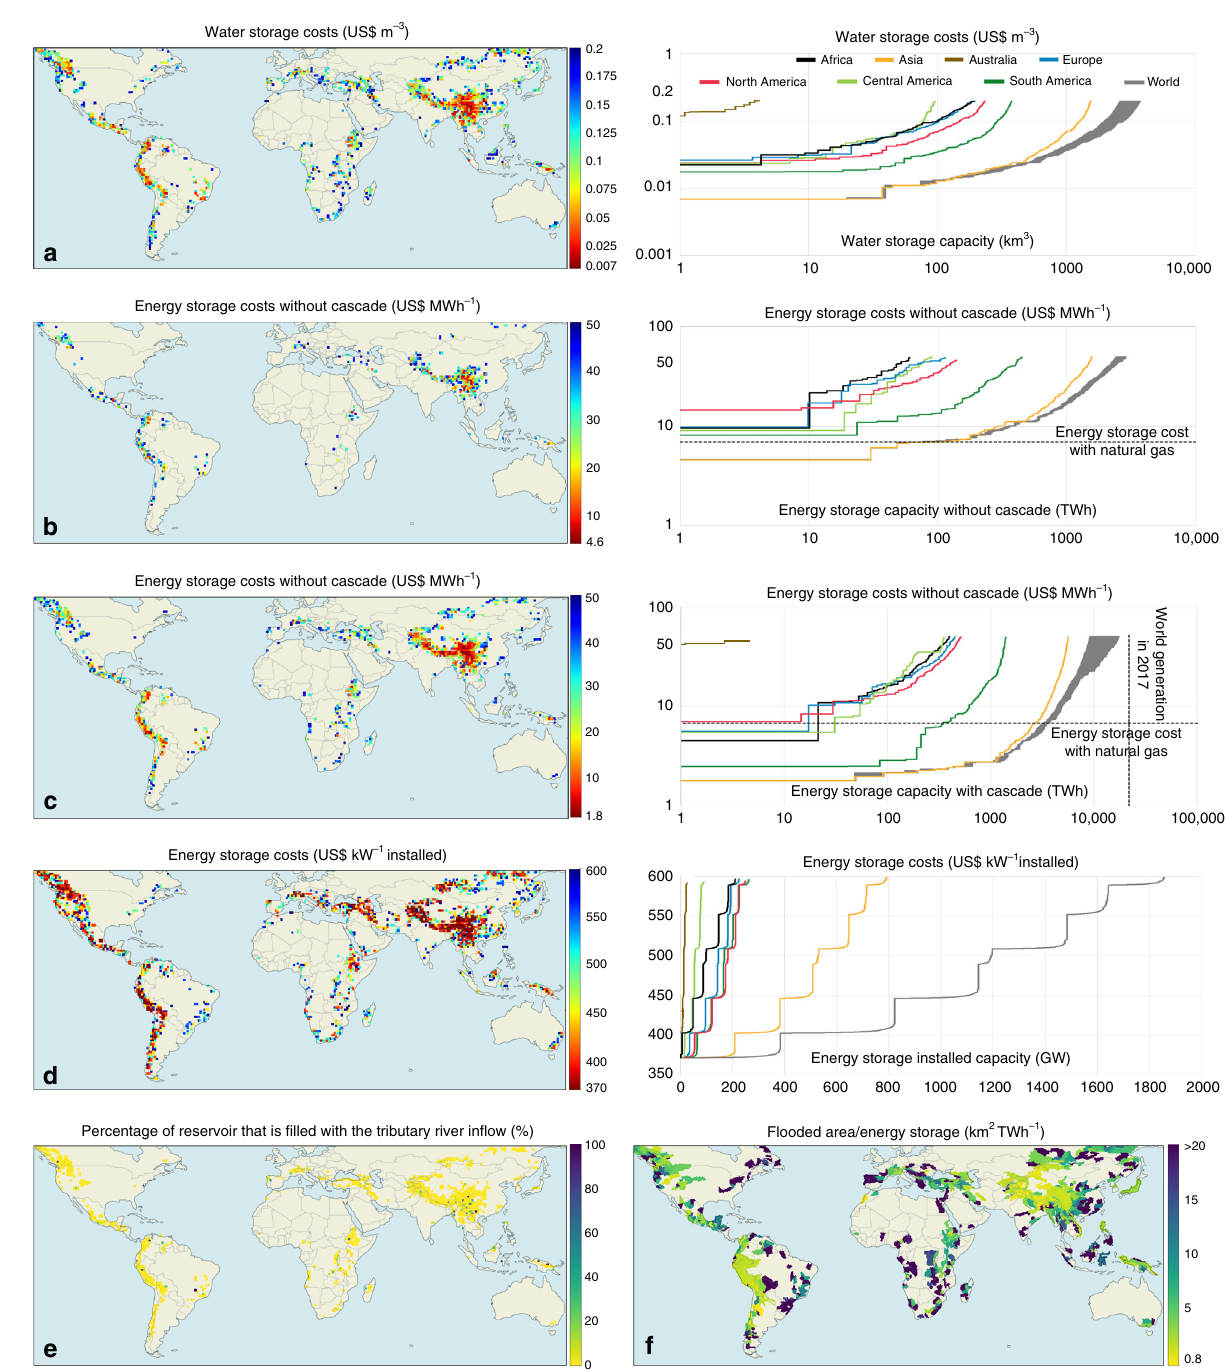
Fig. 2 Seasonal pumped hydropower storage world cost and fl ooded area maps. a Water storage costs and capacity curve in km 3 . b Energy storage without considering hydropower plants in cascade costs and capacity curve in US$ MWh − 1 . c Energy storage considering hydropower plants in cascade costs and capacity curve in US$ MWh − 1 . d Additional generation capacity costs and capacity curve in US$ kW − 1 . e Percentage of the reservoir that is fi lled with the river in fl ow into the SPHS reservoir. f Average land requirement for energy storage in different